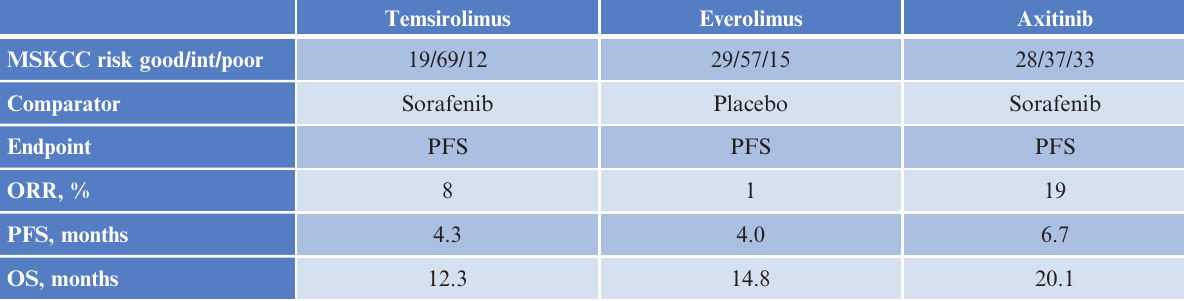
Table 1. Second-line trials (INTORSECT/RECORD